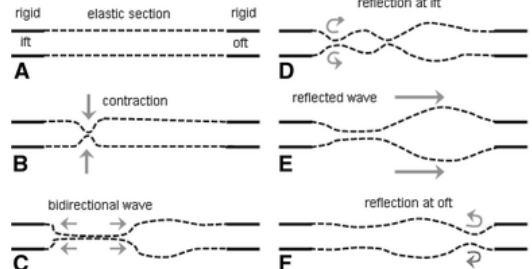
Fig. 3: Schematic diagram illustrating dynamic suction pumping [20]. (A) The flexible tube is at rest, assuming the inflow tract (ifl) is on the left and outflow tract (oft) on the right. (B) Active contraction of the tube in a non-central location along the tube. (C) Contraction induces an elastic passive bidirectional wave to propagate along the tube. (D) Wave reflects off rigid portion of the tube on side nearest to contraction point. (E) The reflected wave travels down the tube. (F) The waves reflect off the rigid section at the far side of the tube. Notice the the reflected wave amplitude is smaller than the reflected wave off the other